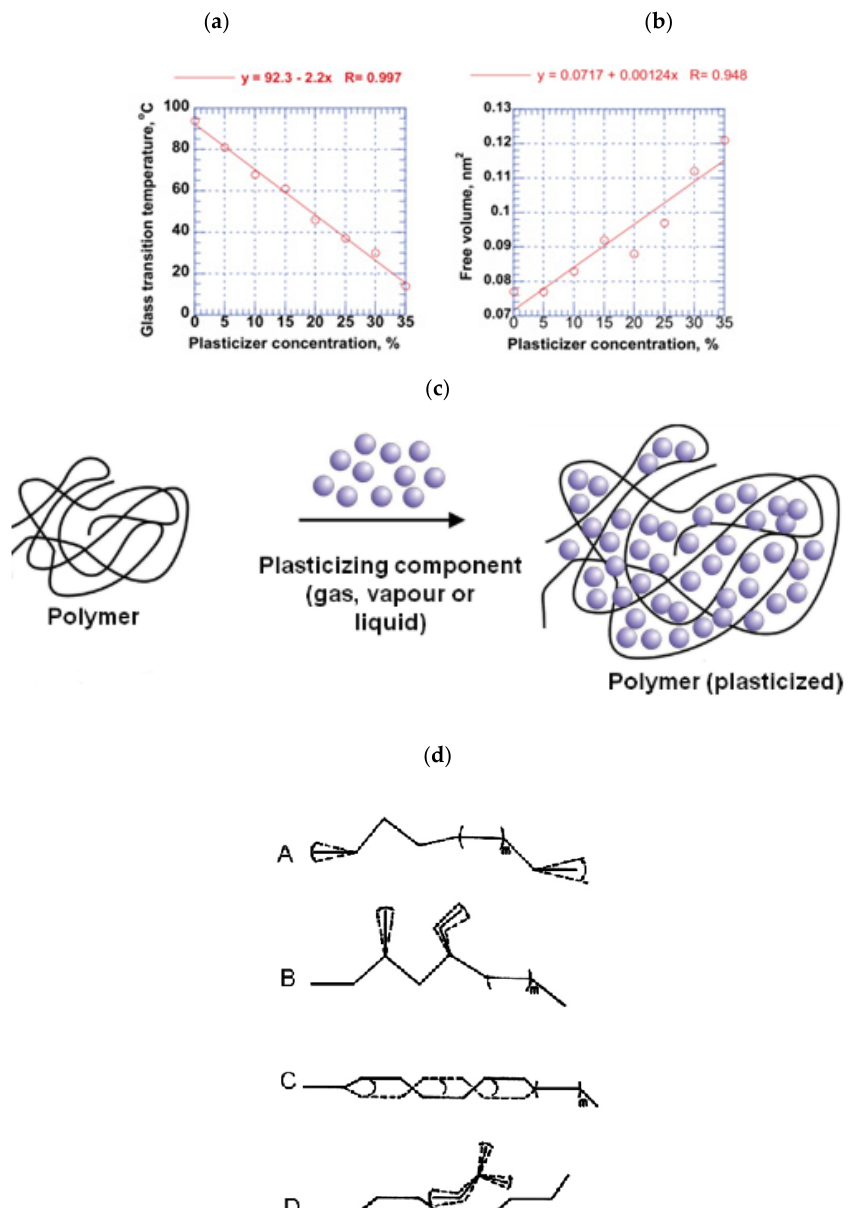
Figure 2. Effect of plasticizer (tricresyl phosphate) on Tg ( a ) and free volume ( b ) of PVC polymer [59]. ( c )—The plasticization phenomenon in polymers [15]. ( d )—Free volume for plasticization sources: ( A ) chain end motion; ( B ) side-chain motion, ( C ) main chain “Crankshaft”, ( D ) external plasticizer motion [59].